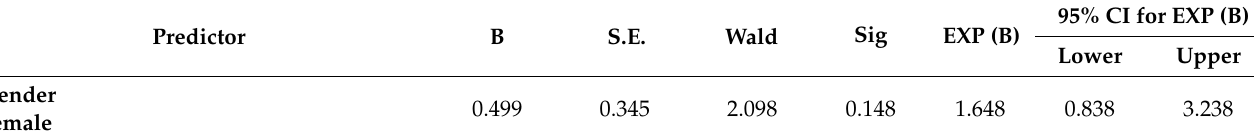
Table 5. Logistic regression predicting likelihood for respondents to present with likely